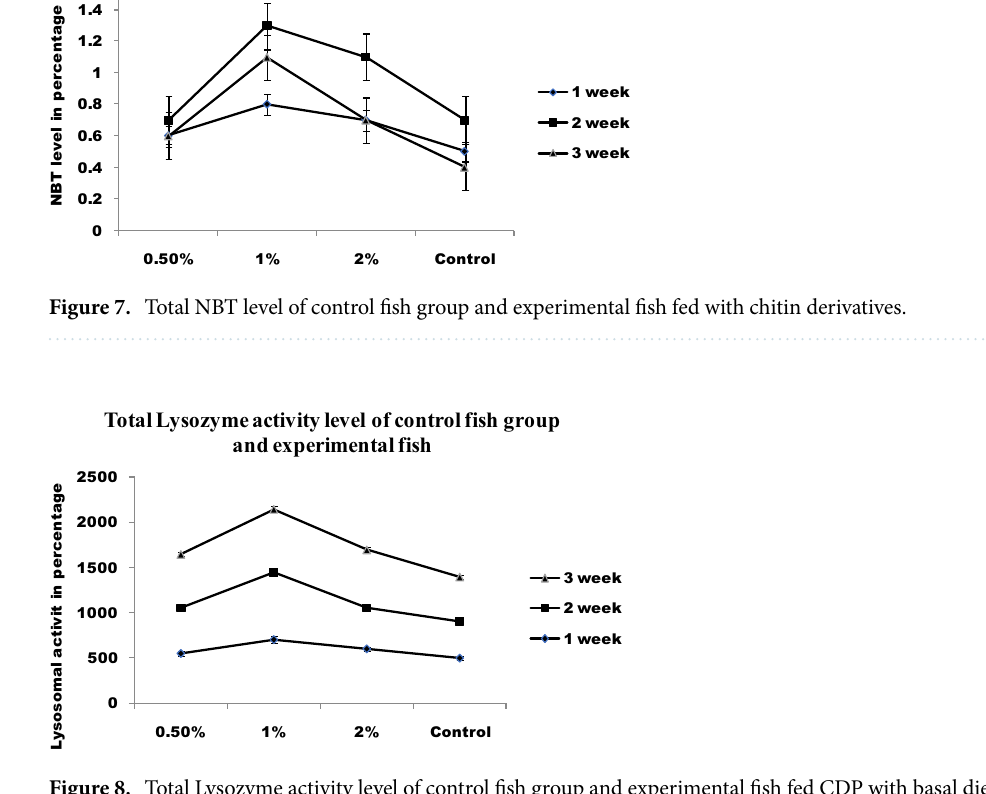
Figure 8. Total Lysozyme activity level of control fish group and experimental fish fed CDP with basal